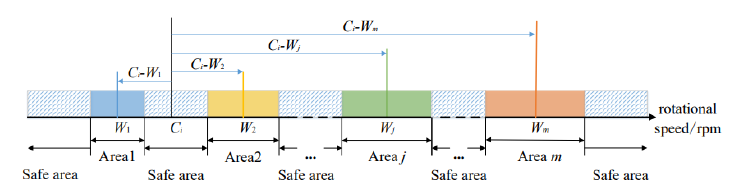
Figure 3. Schematic diagram of the relationship between critical speed and working speed.